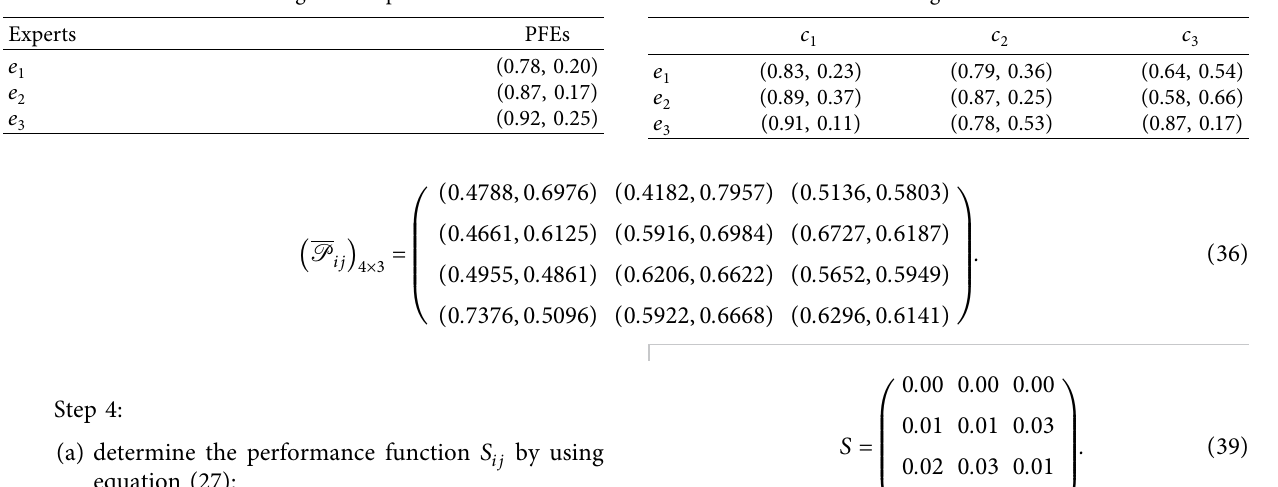
Table 2: Weights of experts. Table 3: Weights of